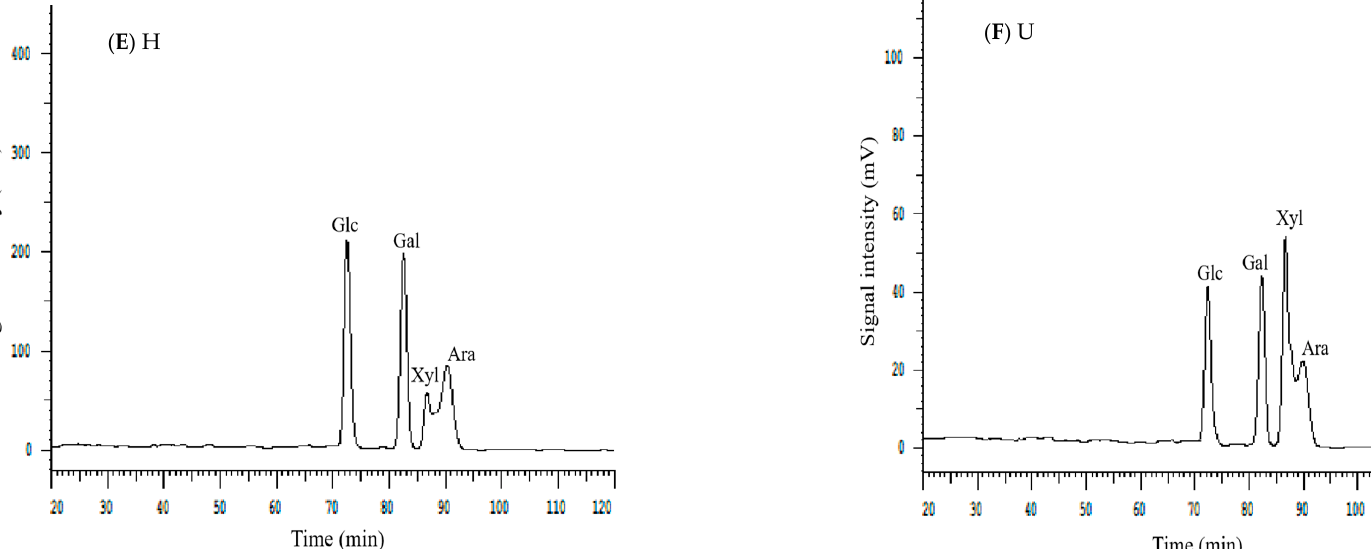
Figure 3. HPLC grams of monosaccharide standards and monosaccharide compositions in Sanchi flower SDF. ( A ) Standards ( B ), AC, Acid ( C ), AL, Alkali ( D ) EN, Enzyme ( E ), H, Homogenization and ( F ), U, Ultrasonication. Mannose, Man; Ribose, Rib; rhamnose, Rha; Glucuronic acid, GlcA; Galacturonic acid, GalA; Glucose, Glc; Galactose, Gal; Xylose, Xyl; Arabinose; Ara; Fucose, Fuc.